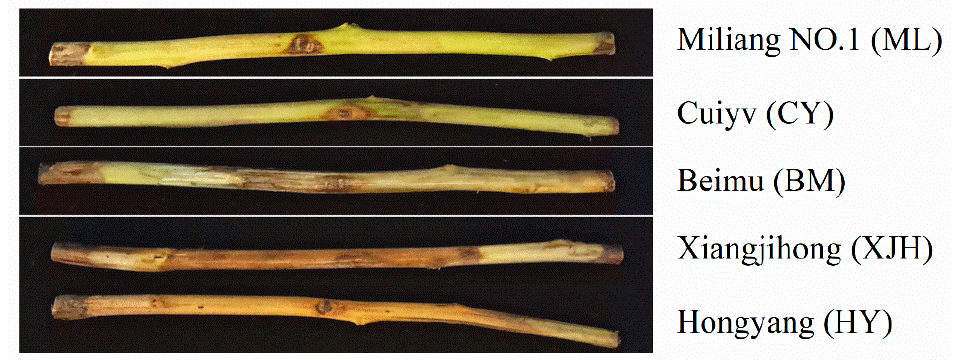
Figure 1. Symptoms of lesions on canes of different cultivars after 30 days inoculation with Pseu- domonas syringae pv. actinidiae (Psa). Table 1. Response of five kiwifruit cultivars to in vitro inoculation with Pseudomonas syringae pv. actinidiae